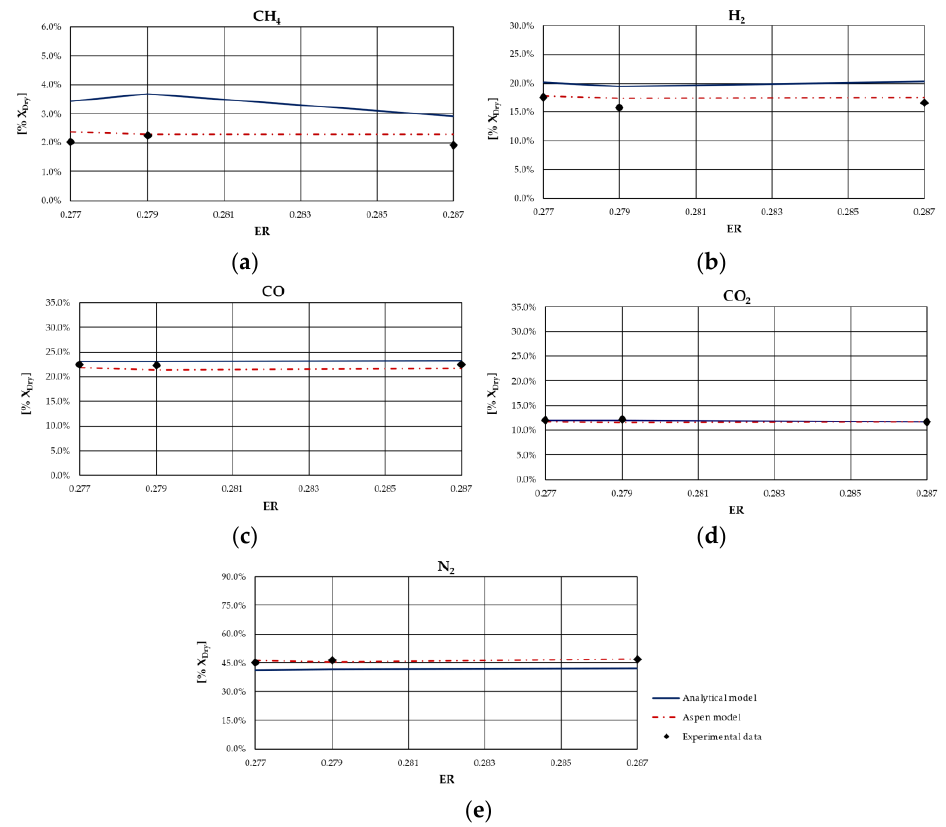
Figure 6. Comparison of syngas mole fraction composition between the results of analytical and Aspen models and experimental data from corn cob gasification [36]: ( a ) CH 4 mole fraction; ( b ) H 2 mole fraction; ( c ) CO mole fraction; ( d ) CO 2 mole fraction; ( e ) N 2 mole fraction.